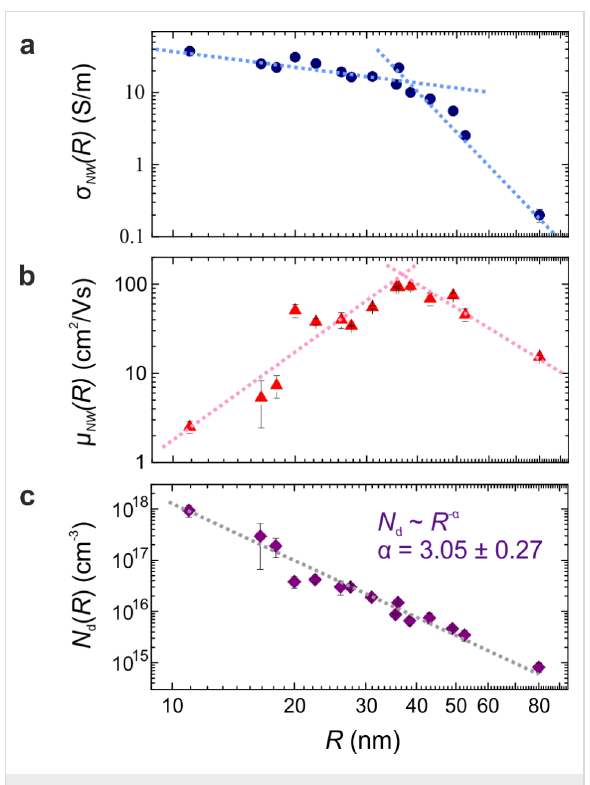
Figure 2: Radius-dependent charge transport properties in Ge NWs. (a) Electrical conductivity, (b) mobility and (c) charge carrier density as function of the NW radius R . Dotted lines in (a) and (b) are a guide to the eye. Grey dashed line in (c) corresponds to the numerical fitting of N d ( R ) with a power function.